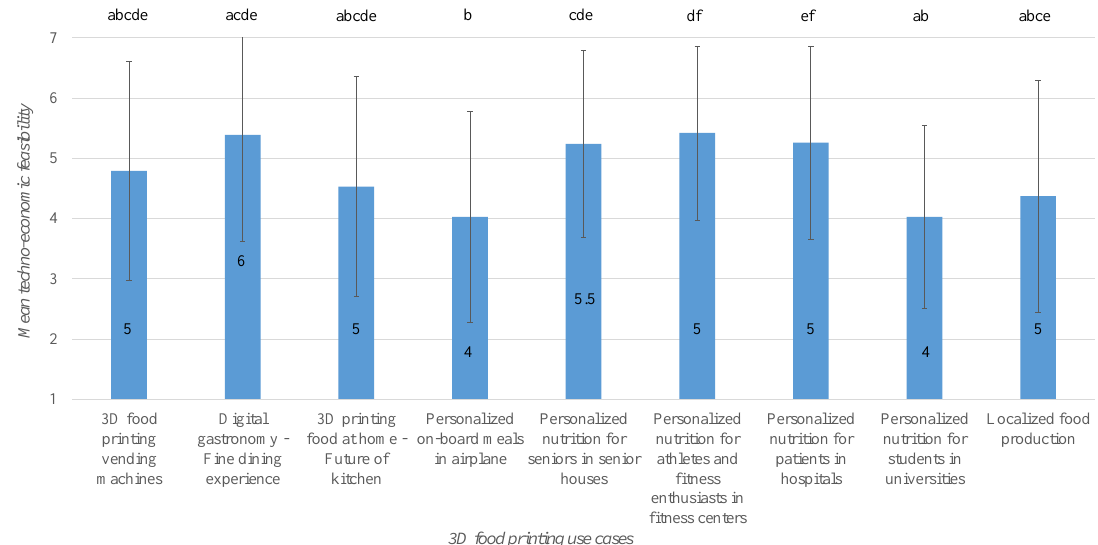
Figure 6. Bar plot of means for techno-economic feasibility of identified 3D food printing use cases. Error indicates the standard deviation, and the number inside the bars indicates median. Bars sharing the same letter are not significantly di ff erent according to Wilcoxon signed rank test.